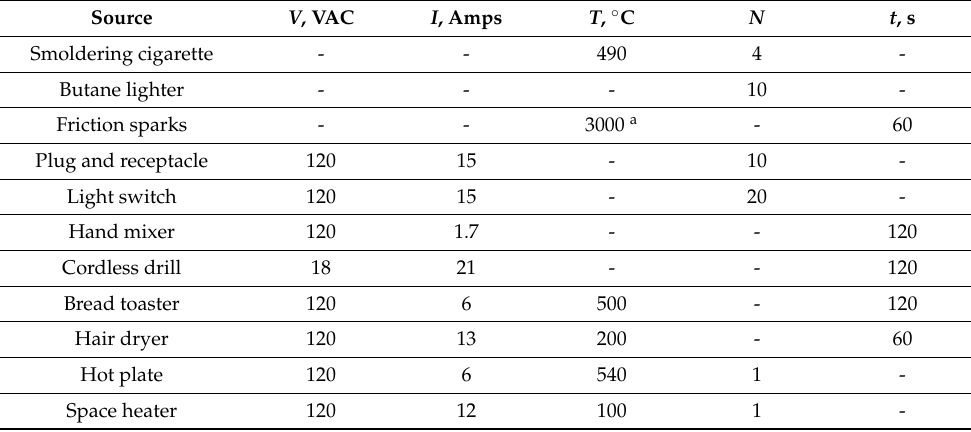
Table 3. List of non-viable ignition